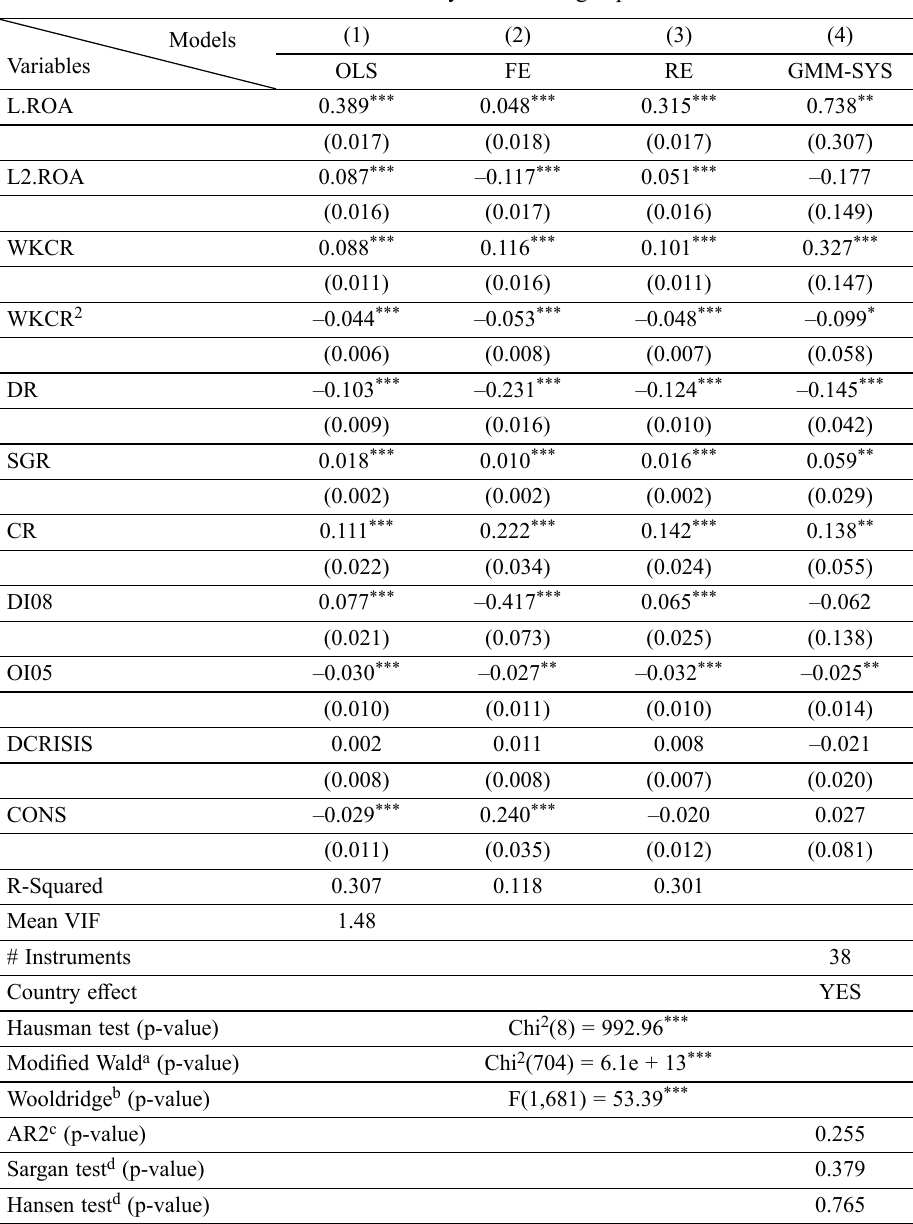
Table 3. Profitability and working